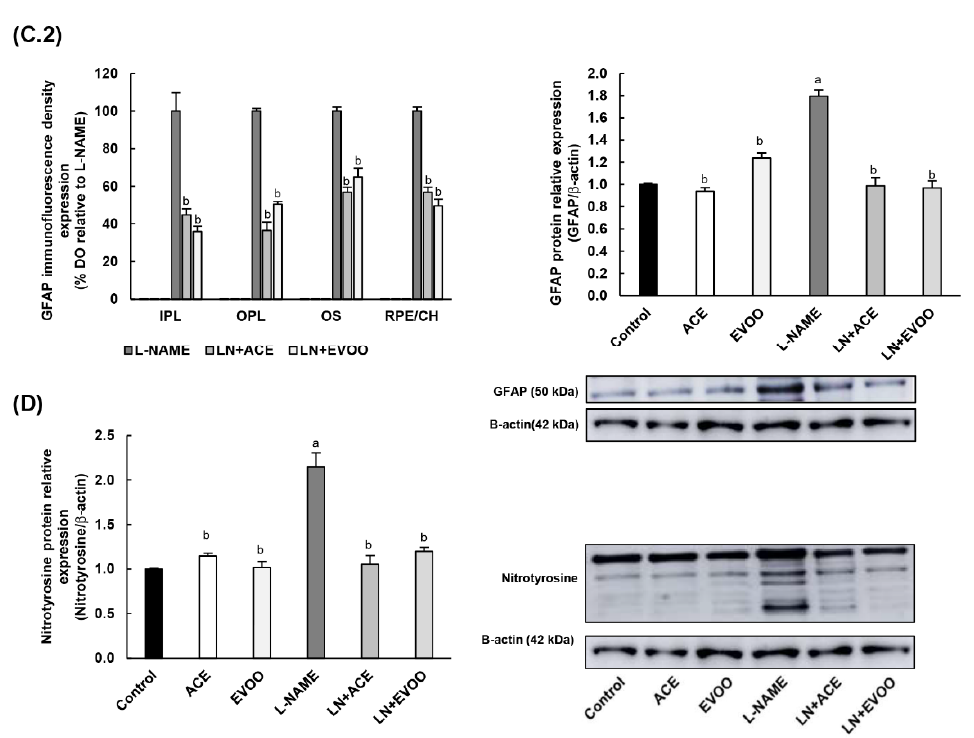
Figure 3. ( A.1 ) Dihydroethidium (DHE) labeling (red color) for reactive oxygen species (ROS) was present in GCL, INL, ONL and OS in the retina, and also in RPE / CH layers, which can be distinguishedwith4 (cid:48) ,6-diamidino-2-phenylindole(DAPI,bluecolor)nucleistaining. Middlelinephotos in the panel represent the e ff ects of preincubation with polyethylene glycol-conjugated superoxide dismutase (PEG-SOD). ( A.2 ) Fluorescence intensity in ( A.1 ) relative to that of control group and quantified using Image J software. ( B.1 ) DHE labeling in retinas from L-NAME-treated mice following preincubation with specific nicotinamide adenine dinucleotide phosphate (NADPH) oxidase (NOX) inhibitors: NOX pan-inhibitor (VAS2870), dual NOX1 / NOX4 inhibitor (GKT136901) and NOX1 inhibitor (ML171). ( B.2 ) Relative fluorescence intensity in ( B.1 ) relative to that of control group and quantified using the Image J software. ( C.1 ) Localization / expression of GFAP in retinal layers, with further quantification by measurement of fluorescence intensity and by Western blotting of retinal homogenates ( C.2 ). ( D ) Nitrosylation of proteins estimated by Western blotting in retinal homogenates. Magnification: 10 × . Values are expressed as mean ± SEM of four animals per group: a p < 0.05 vs. control; b p < 0.05 vs. L-NAME; c p < 0.05 vs. EVOO; d p < 0.05 vs. LN + EVOO; e p < 0.05 vs. ACE; * p < 0.05